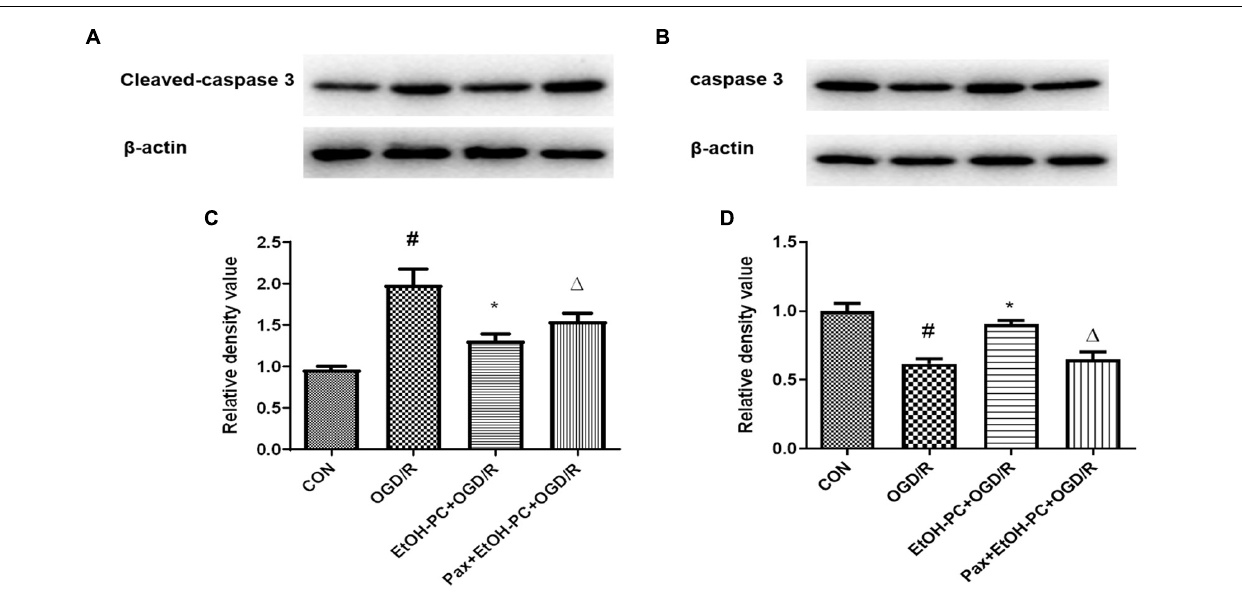
FIGURE 7 | Ethanol preconditioning downregulated the cleaved caspase 3 expression through activating mitoBK Ca . After the neurons were preincubated with paxilline (5 µ mol/L) for 10 min and preconditioned with ethanol (10 mmol/L) followed by OGD2h/R24h, cleaved caspase 3 and total caspase 3 were detected by Western blot analysis. Representative blots in (A) cleaved caspase 3 and (B) total caspase 3. Quantification of the ratio of cleaved caspase 3 to β -actin (C) and total caspase 3 to β -actin (D) . Results are expressed as mean ± S.D. ( n = 3). # P < 0.01 vs. CON; * P < 0.01 vs. OGD/R; (cid:49) P < 0.01 vs. EtOH-PC + OGD/R (C) . # P < 0.01 vs. CON; * P < 0.01 vs. OGD/R; (cid:49) P < 0.01 vs. EtOH-PC + OGD/R (D) .